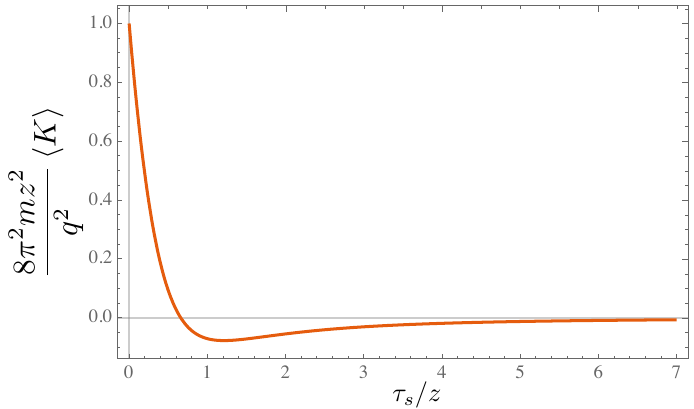
Figure 4 . Late time behaviour of the quantum contribution to the kinetic energy of the charged particle due to vacuum (cid:13)uctuations near a conducting